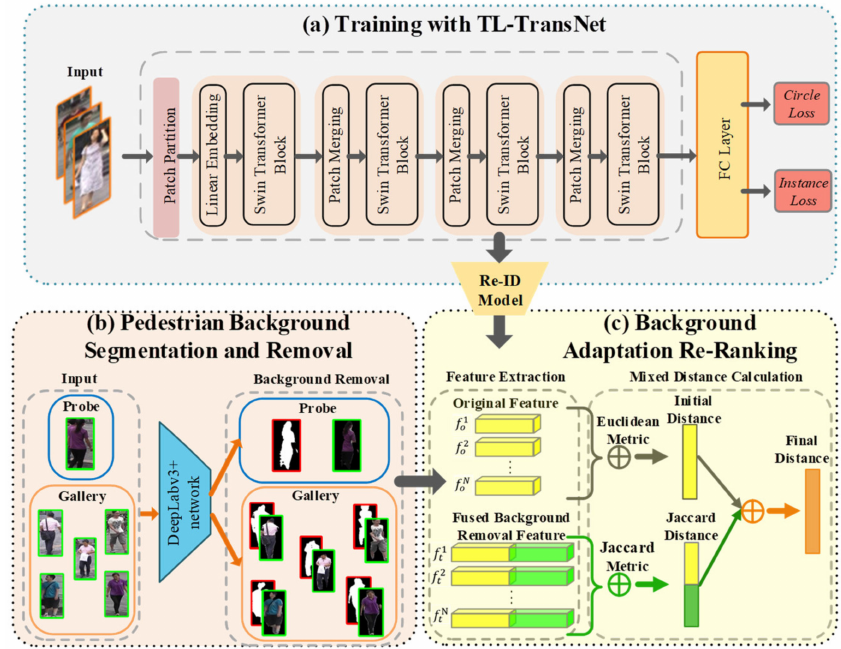
Figure 2. Framework of the proposed method for person